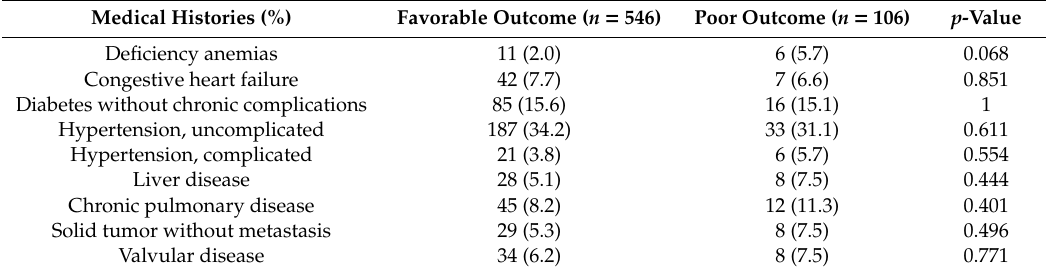
Table 3. Univariate analysis of the medical history